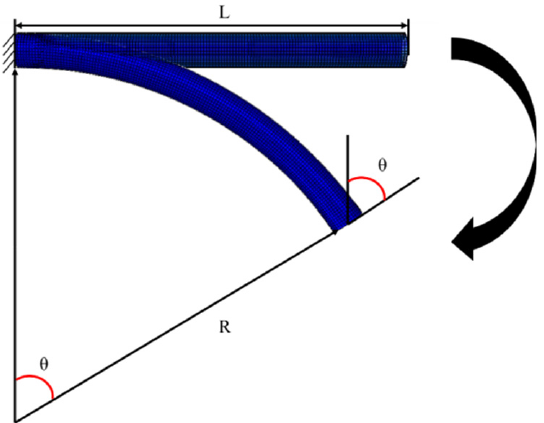
Figure 11. Schematicdiagram of the bending radius of the RTP.